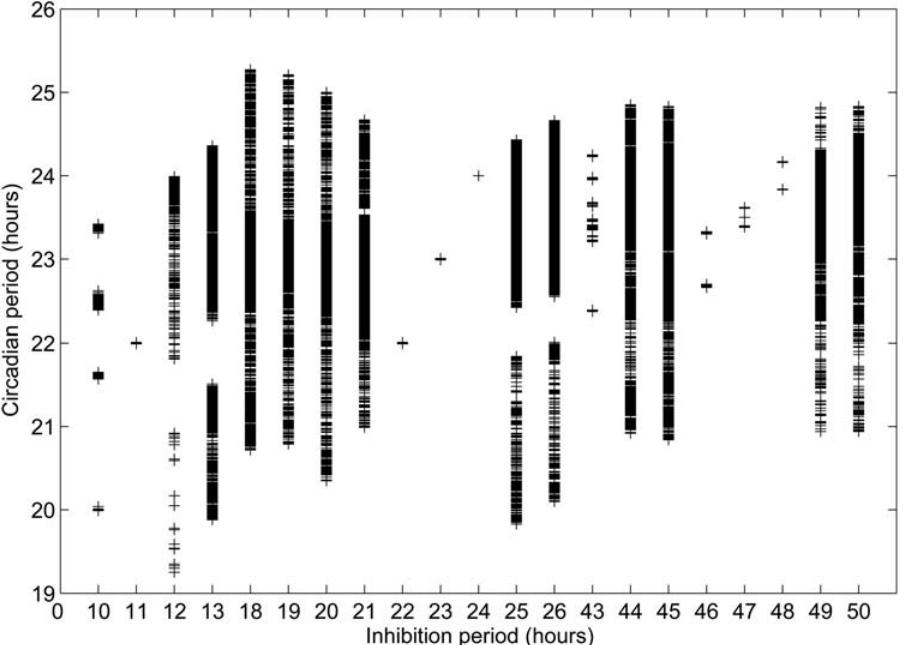
Figure 2. Effects of cell cycle M-phase on circadian periods. Cell cycle M-phase is introduced into the mammalian circadian model as transcriptional inhibition cycles of different periods. For each period, transcriptional inhibitions are imposed at various circadian phases with an interval of 30 minutes. The resulting models are simulated. Simulation data are sampled at equilibrium state and circadian periods are calculated for each simulation. The calculated periods are combined and plotted against transcriptional inhibition periods.